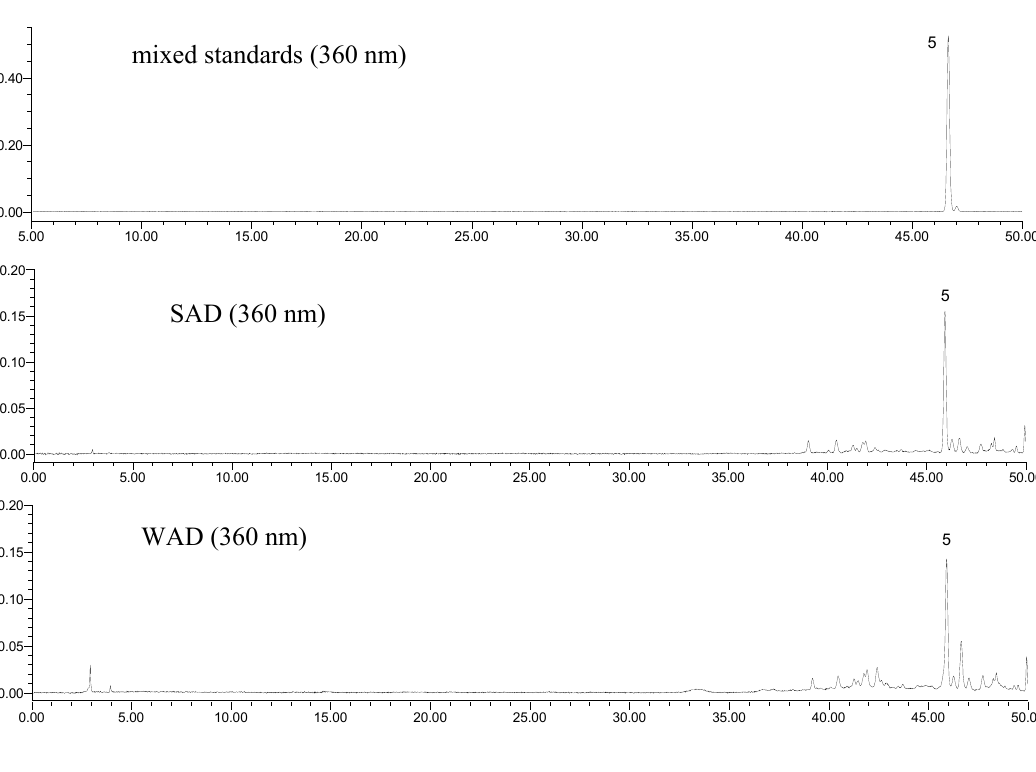
Figure 4. Typical HPLC chromatograms of mixed standards and the investigated samples at 360 nm. ephedrine ( 1 ), amygdalin ( 2 ), liquiritin ( 3 ), benzoic acid ( 4 ), isoliquiritin ( 5 ), formononetin ( 6 ) and glycyrrhizic acid ( 7